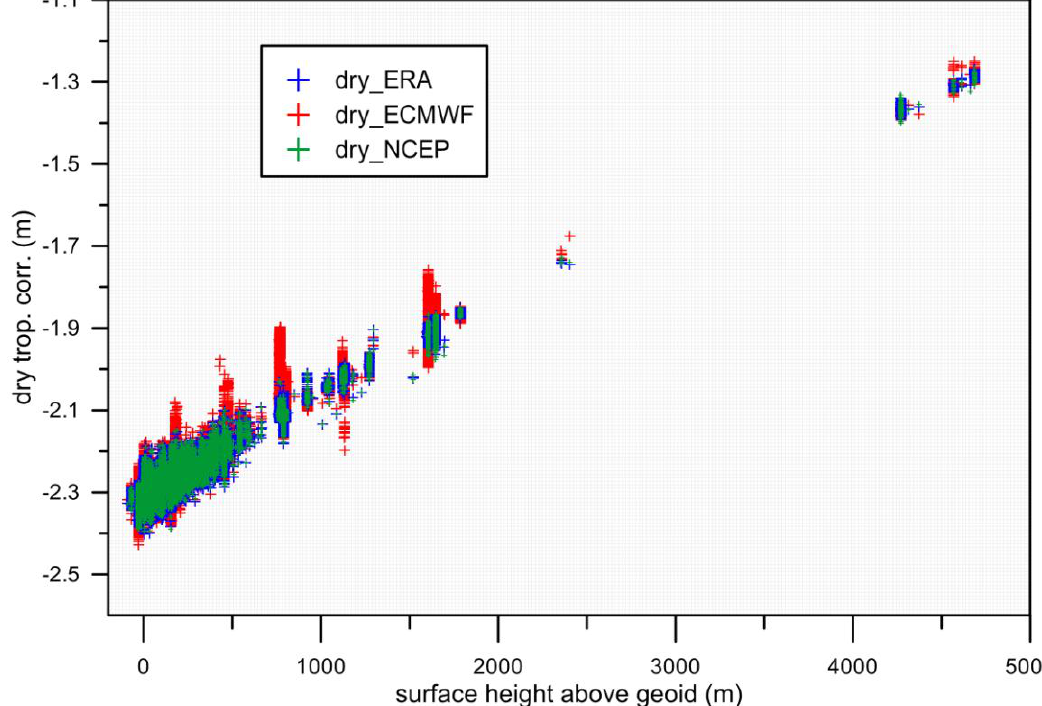
Figure 2. ( Top ) Dry tropospheric correction from three models as present in RADS: ECMWF operational (red), ERA interim (blue) and NCEP (green), in meters, versus surface height above the EGM2008 geoid (m) for Jason-1 (all points for all Phase A cycles, 1 to 259). Similar plots are obtained for Jason-2, Envisat, CryoSat-2 and SARAL. ( Bottom ) The same as in the top plot for TOPEX/Poseidon (T/P) (all cycles for Phase A, 1 to 364). Similar plots are obtained for all ERS-2 and ERS-1 analyzed cycles. See the text for further